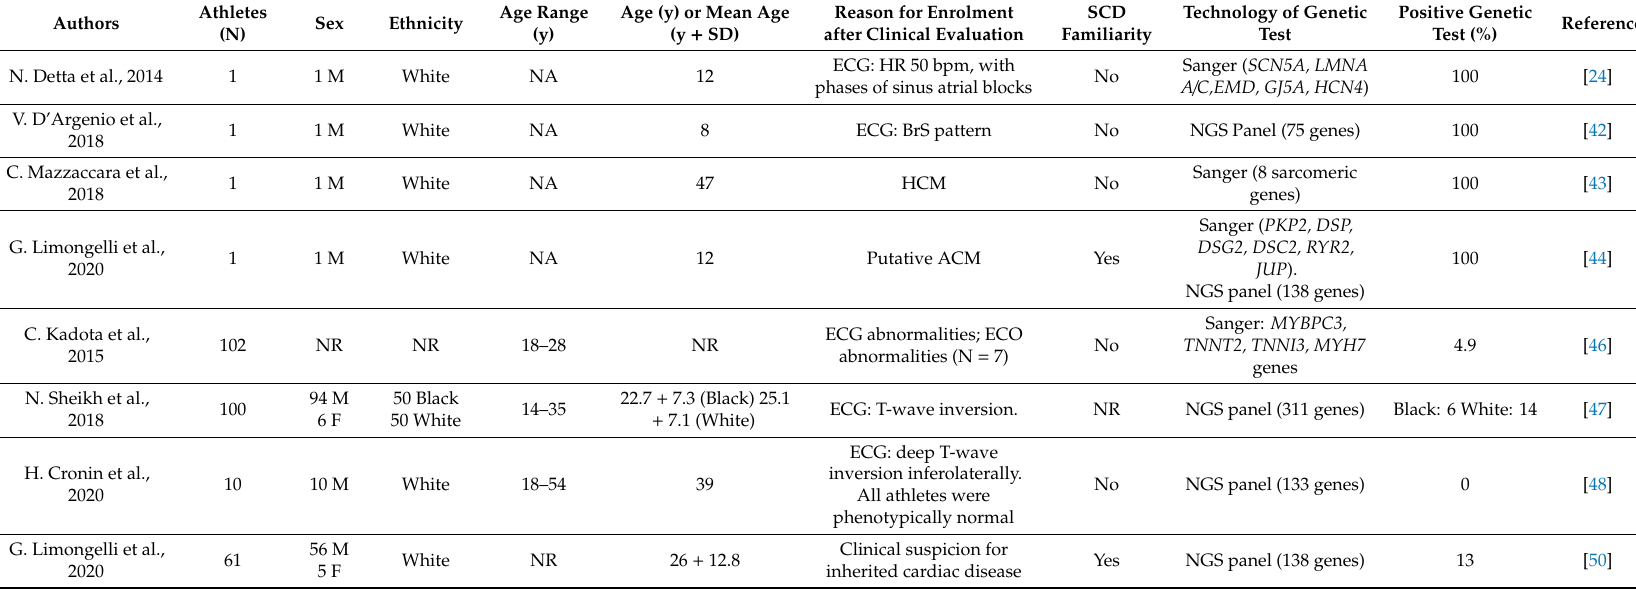
Table 2. Summary of the Literature Data Concerning the Use of Genetic Tests to Diagnose Cardiomyopathy / Channelopathy in Athlete(s).